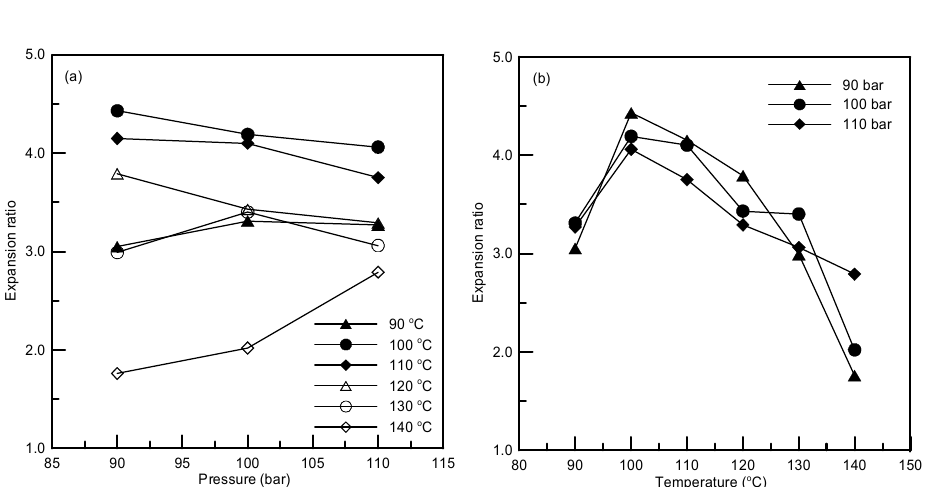
Figure 6. Effect of saturation condition on the expansion ratio of microcellular foam of TPU: ( a ) effect of saturation pressure, ( b ) effect of saturation